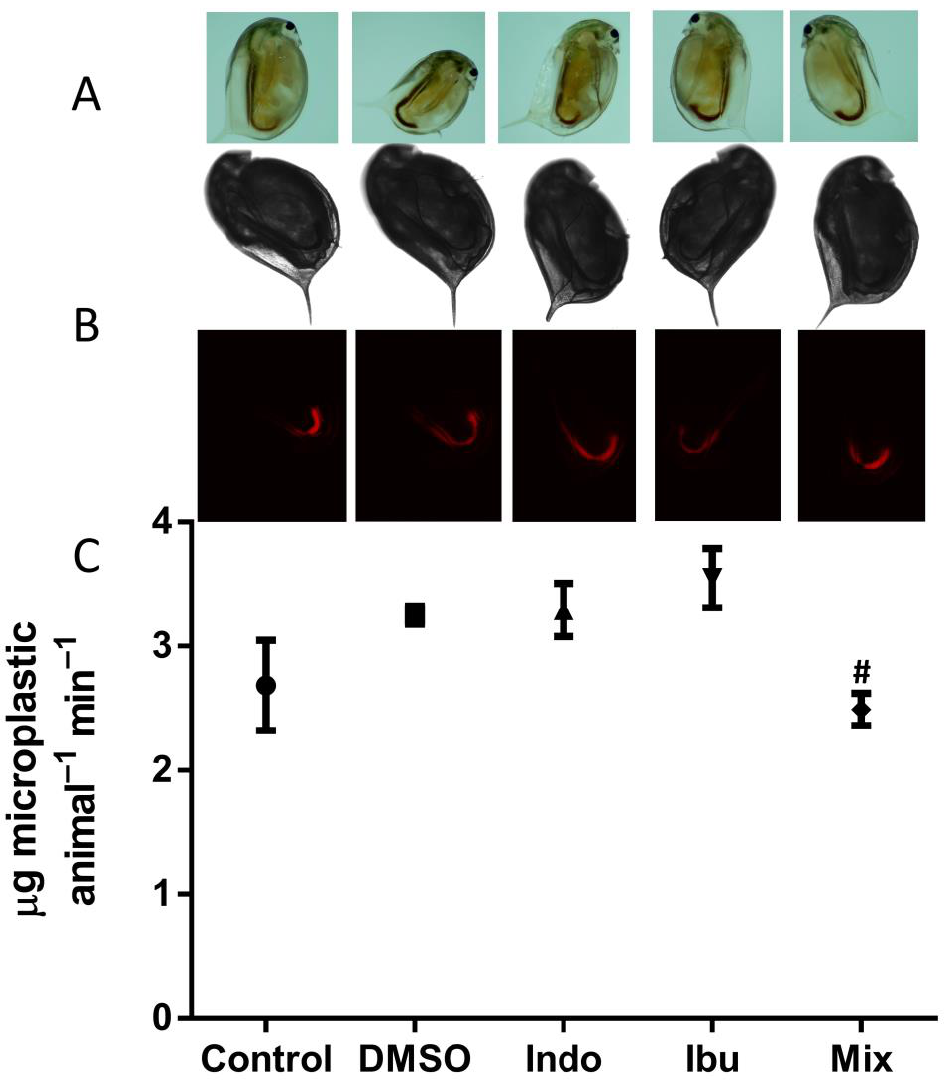
Figure 4. The impact of NSAIDs on feeding rate to D5 daphnids. The ingested microparticles were visualized by optical stereoscopy ( Panel A ), bright field, and fluorescence microscopy ( Panel B ). Feeding rate was quantified by the ingestion of microparticles based on their fluorescence in the incubation media ( Panel C ). Data represent average ± standard deviation (N = 5 replicates). # Statistically significant by Student’s t -test denotes significant difference in comparison to the DMSO carrier solvent.